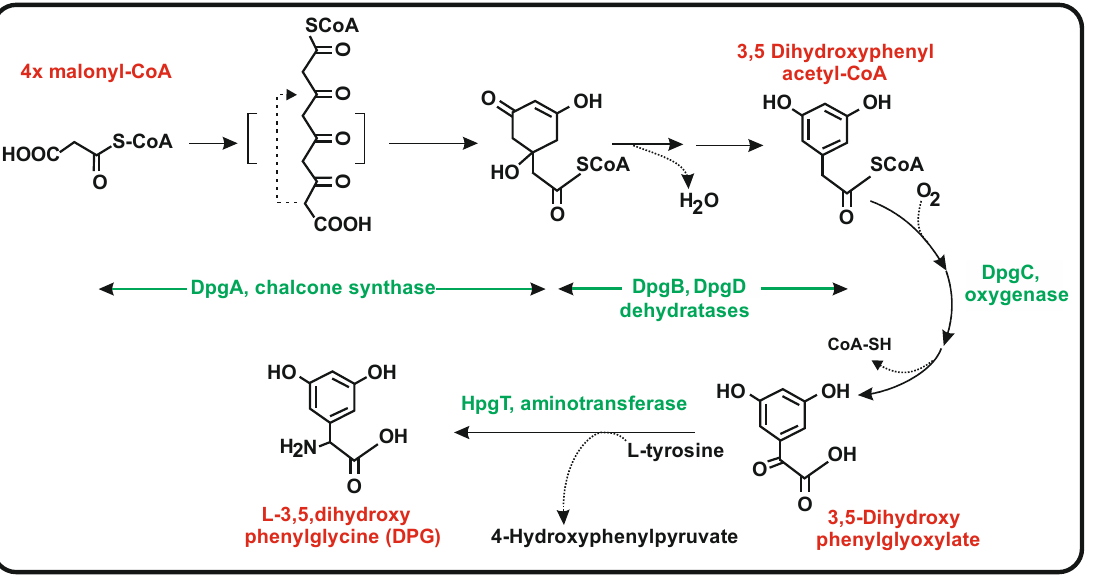
Figure 8. Biosynthesis of L-3,5, dihydroxyphenylglycine. The name of the enzyme involved in every step is indicated in green letters. Some steps have been proposed to consist of more than one reaction [98]. Only the putative intermediate formed by DpgA is shown.